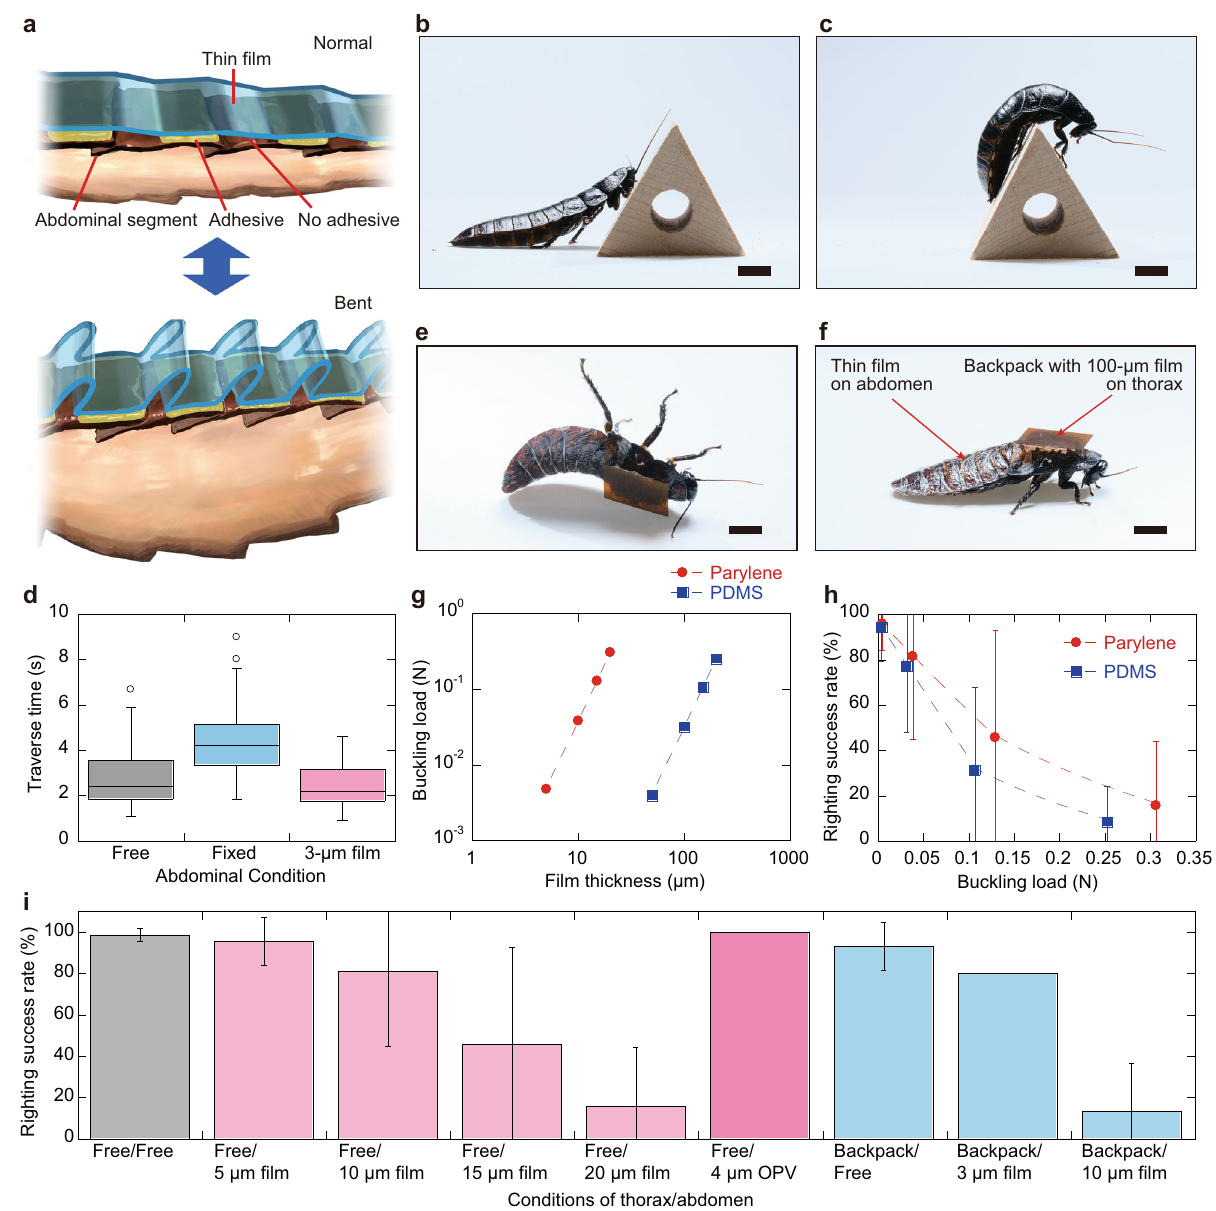
Fig. 2 Fundamental behavioural ability with electronics. a Schematic cross-sectional illustration of abdominal segments with thin fi lms attached using an adhesive-nonadhesive interleaving structure. The interleaving structure enables outward bending of the thin fi lms during the deformation of the abdomen. b , c Images of traversing the obstacle near the starting point ( b ) and near the end point ( c ). Scale bars, 10 mm. d Box-plots of traversing time under various abdominal conditions. Left: free condition with no fi lm, Centre: abdomen is fi xed with a thick fi lm, Right: 3 µm thick parylene fi lm was adhered onto the abdomen with interleaving structure. Center line, median; box limits, upper and lower quartiles; whiskers, 1.5x interquartile range; points, outliers. e , f Photographs of the self-righting attempt while the insect was upside-down ( e ) and after a successful attempt ( f ). Scale bars, 10 mm. g Calculated buckling load of the fi lms attached to the abdomen as a function of the fi lm thickness. Red circles and blue squares represent the parylene fi lm ( E = 4.0 GPa) and PDMS fi lm ( E = 3.3 MPa), respectively. h Righting success rate as a function of the buckling load. Red circles and blue squares represent parylene and PDMS fi lm. i Righting success rate for various thoracic and abdominal conditions. The error bars in h , and i represent the standard deviations for each